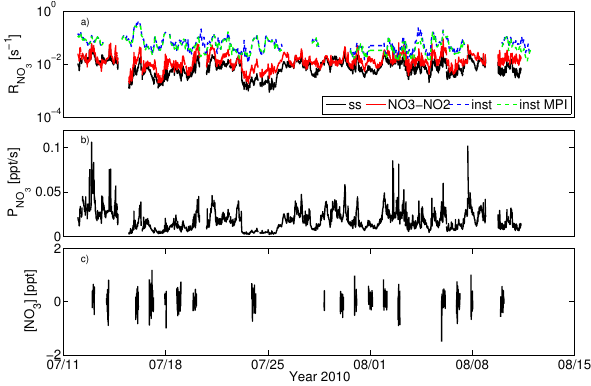
Figure 10. (a) The steady state (ss, in black) and instantaneous (inst, in dashed blue, when using Figure 14. (a) The steady state (ss, in black) and instantaneous SMEAR II NO X concentrations, inst MPI, in dashed green, when using MPI NO X concentrations) (inst, in dashed blue, when using SMEAR II NO x concentrations, NO 3 -reactivity ( R NO ) together with the the corrected steady state reactivity where also the reactions 3 inst MPI, in dashed green, when using MPI NO x concentrations) of NO 3 with NO 2 have been taken into account ( NO 3 - NO 2 , in red), (b) the production term ( P NO k 6 [NO 2 ][O 3 ] ) of NO 3 , and (c) the measured concentration of NO 3 ([ NO 3 ]). Please note the log scale NO 3 reactivity ( R NO ) together with the corrected steady-state re- 3 in the a section. activity where also the reactions of NO 3 with NO 2 have been taken into account (NO 3 –NO 2 , in red), (b) the production term = k [ NO ][ O ] ) of NO ( P NO 6 2 3 3 and (c) the measured concentration 3 of NO 3 ([NO 3 ]). Please note the log scale in the (a)